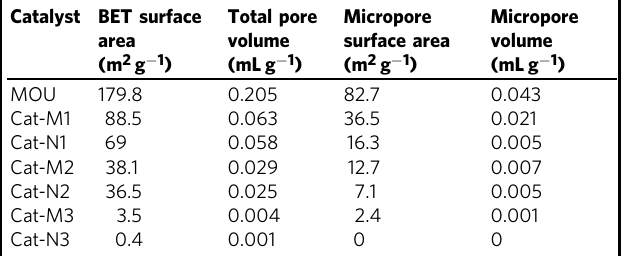
Table 2 Structural properties of fresh and used catalysts with different reaction cycles under methane and nitrogen.